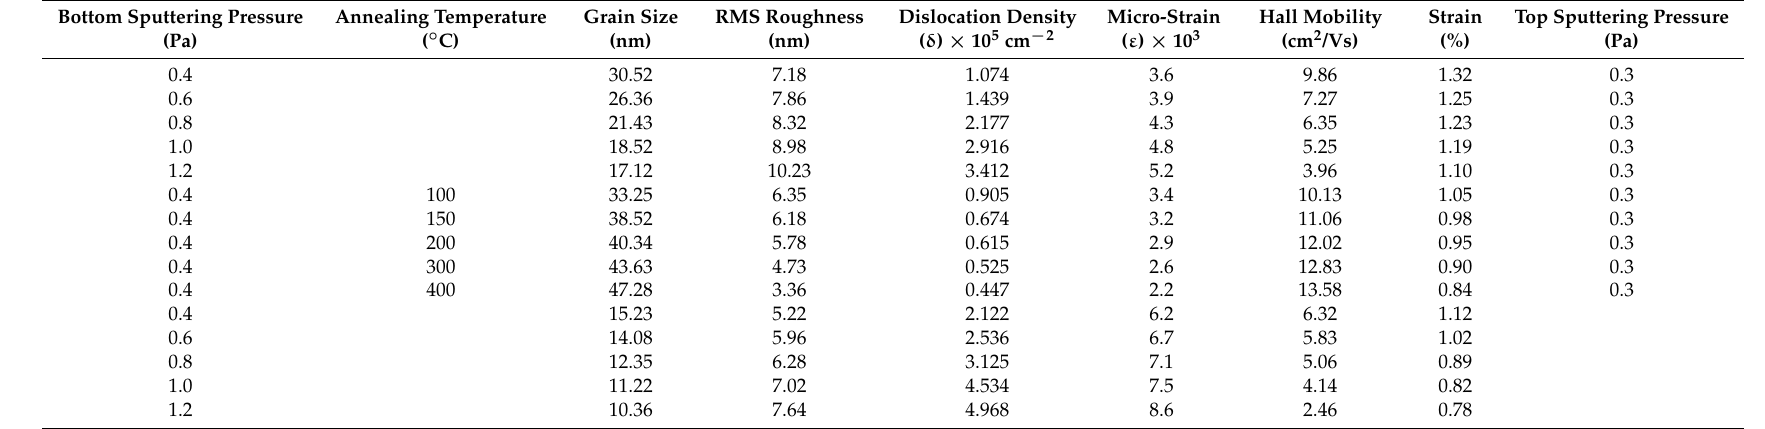
Table 1. Grain size, root mean square (RMS) roughness, dislocation density, micro-strain, strain and Hall mobility of Mo bilayer films deposited by